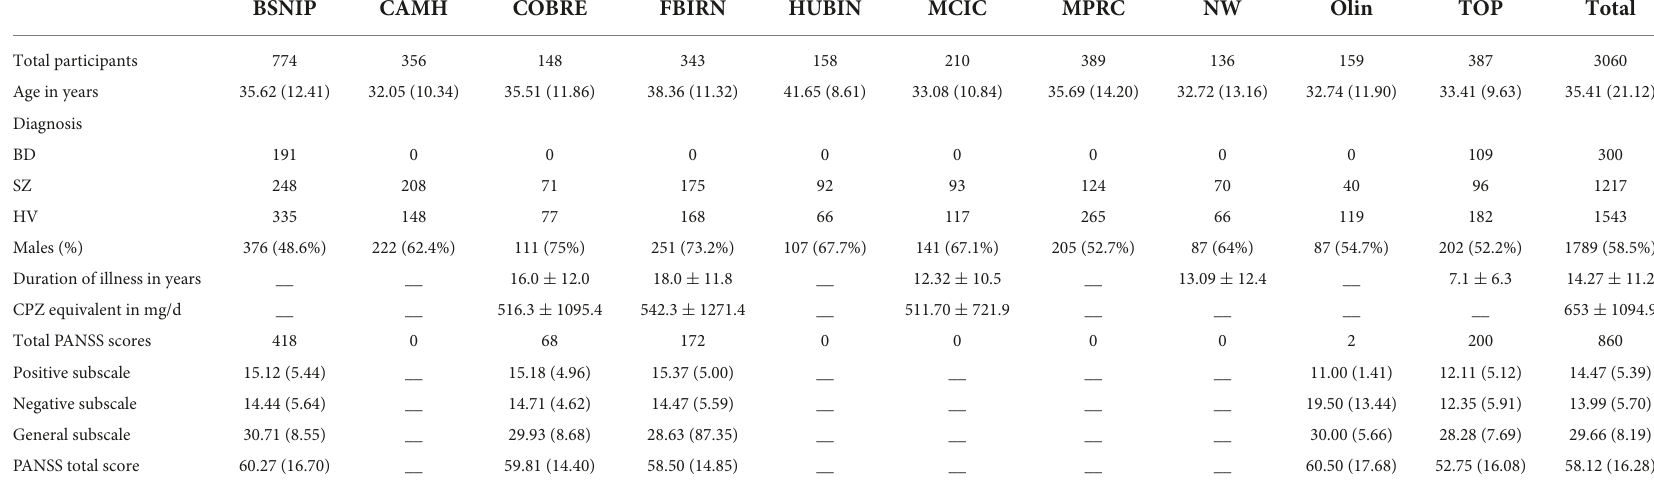
TABLE 2 Demographic information across